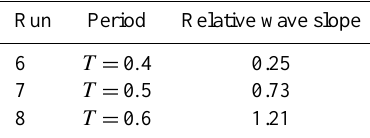
Fig. 5. Photograph of the free surface for run 6, T = 0 . 4s Fig. 5: Photograph of the free surface for run 6, T=0.4s